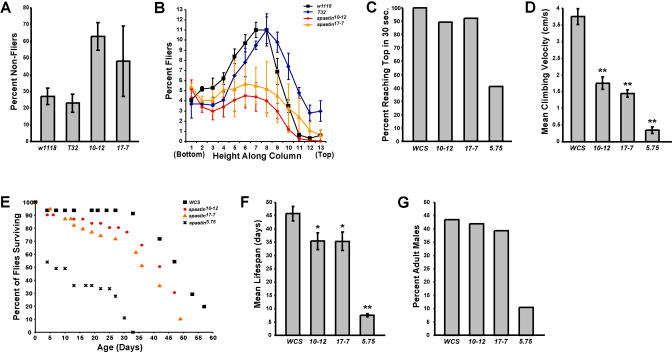

spastin Mutant Flies Have Compromised Motor Behavior and Reduced Lifespans(A) In a flight test assay, over twice as many adult spastin hypomorphs (spastin10-12 and spastin17-7) fail to fly before falling to the bottom of a cylinder, in comparison to w1118 and T32 homozygous controls.(B) Although fewer than half of the hypomorphs fly, compared to more than 70% of controls, the distribution of collision sites of the fliers along the height of the cylinder parallels that of the controls, suggesting that these spastin mutations affect flying ability in some animals but not in others.(C and D) spastin mutants are compromised in their climbing ability. (C) All control (WCS) and nearly all spastin hypomorphs climb to the top of a vial in 30 s, but only 40% of spastin nulls do so. (D) Climbing velocity (measured for those flies that reach the top in 30 s) is 3.8 ± 0.2 cm/s in WCS (n = 45), but only 1.8 ± 0.2 and 1.4 ± 1.1 cm/s in spastin10-12 (n = 28) and spastin17-7 (n = 38) flies, respectively, and 0.3 ± 0.1 cm/s in spastin5.75 null mutants (n = 17; p < 1 × 10−8 for all relative to WCS).(E) Lifespan curves. The curve inflection point at which WCS and hypomorph flies begin to die off at a rapid rate occurs at 30–35 d after eclosion, and more than 70% of hypomorph flies and 95% of wild-type flies are still alive at 30 d. In contrast, approximately 45% of spastin5.75 null mutant flies die prior to 4 d after eclosion. However, the majority of the remaining null flies survive more than 25 d, so that the curve inflection point for nulls occurs only a few days before that for controls and hypomorphs.(F) Mean lifespan is 46 ± 2.7 d in WCS controls (n = 39) compared to 35 ± 3.2 and 35 ± 3.4 d, respectively, in spastin10-12 (n = 24, p < 0.02) and spastin17-7 (n = 32, p < 0.006), and 7.6 ± 0.6 d in nulls (n = 62, p < 10−31).(G) Only about 10% of spastin5.75 flies eclosing at room temperature are males, while 40%–45% are males for controls and hypomorphs.